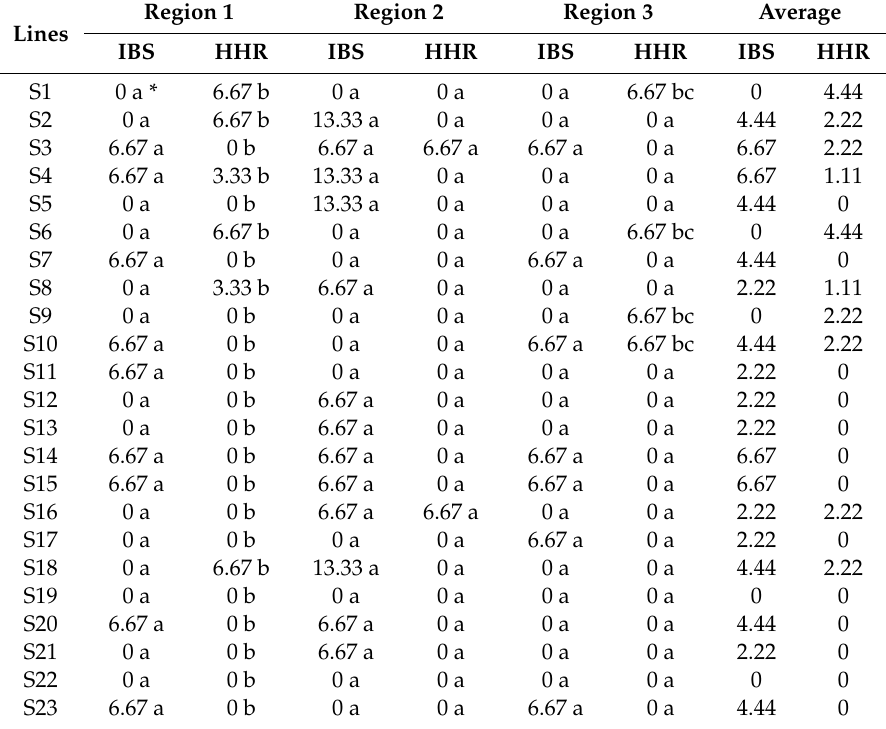
Table 2. Internal brown spot (IBS) (%) and hollow heart occurred rate (HHR) (%) of 35 potato lines grown in three di ff erent agro-ecological regions in South